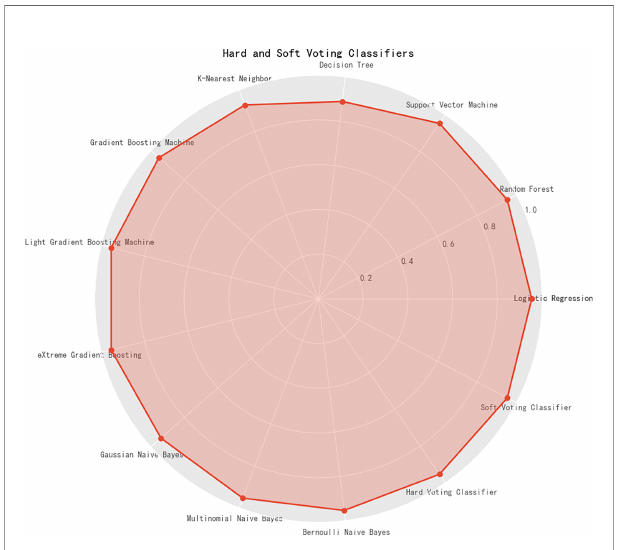
FIGURE 1 | The prediction accuracy of 13 machine learning algorithms, along with hard and soft voting classi fi ers.